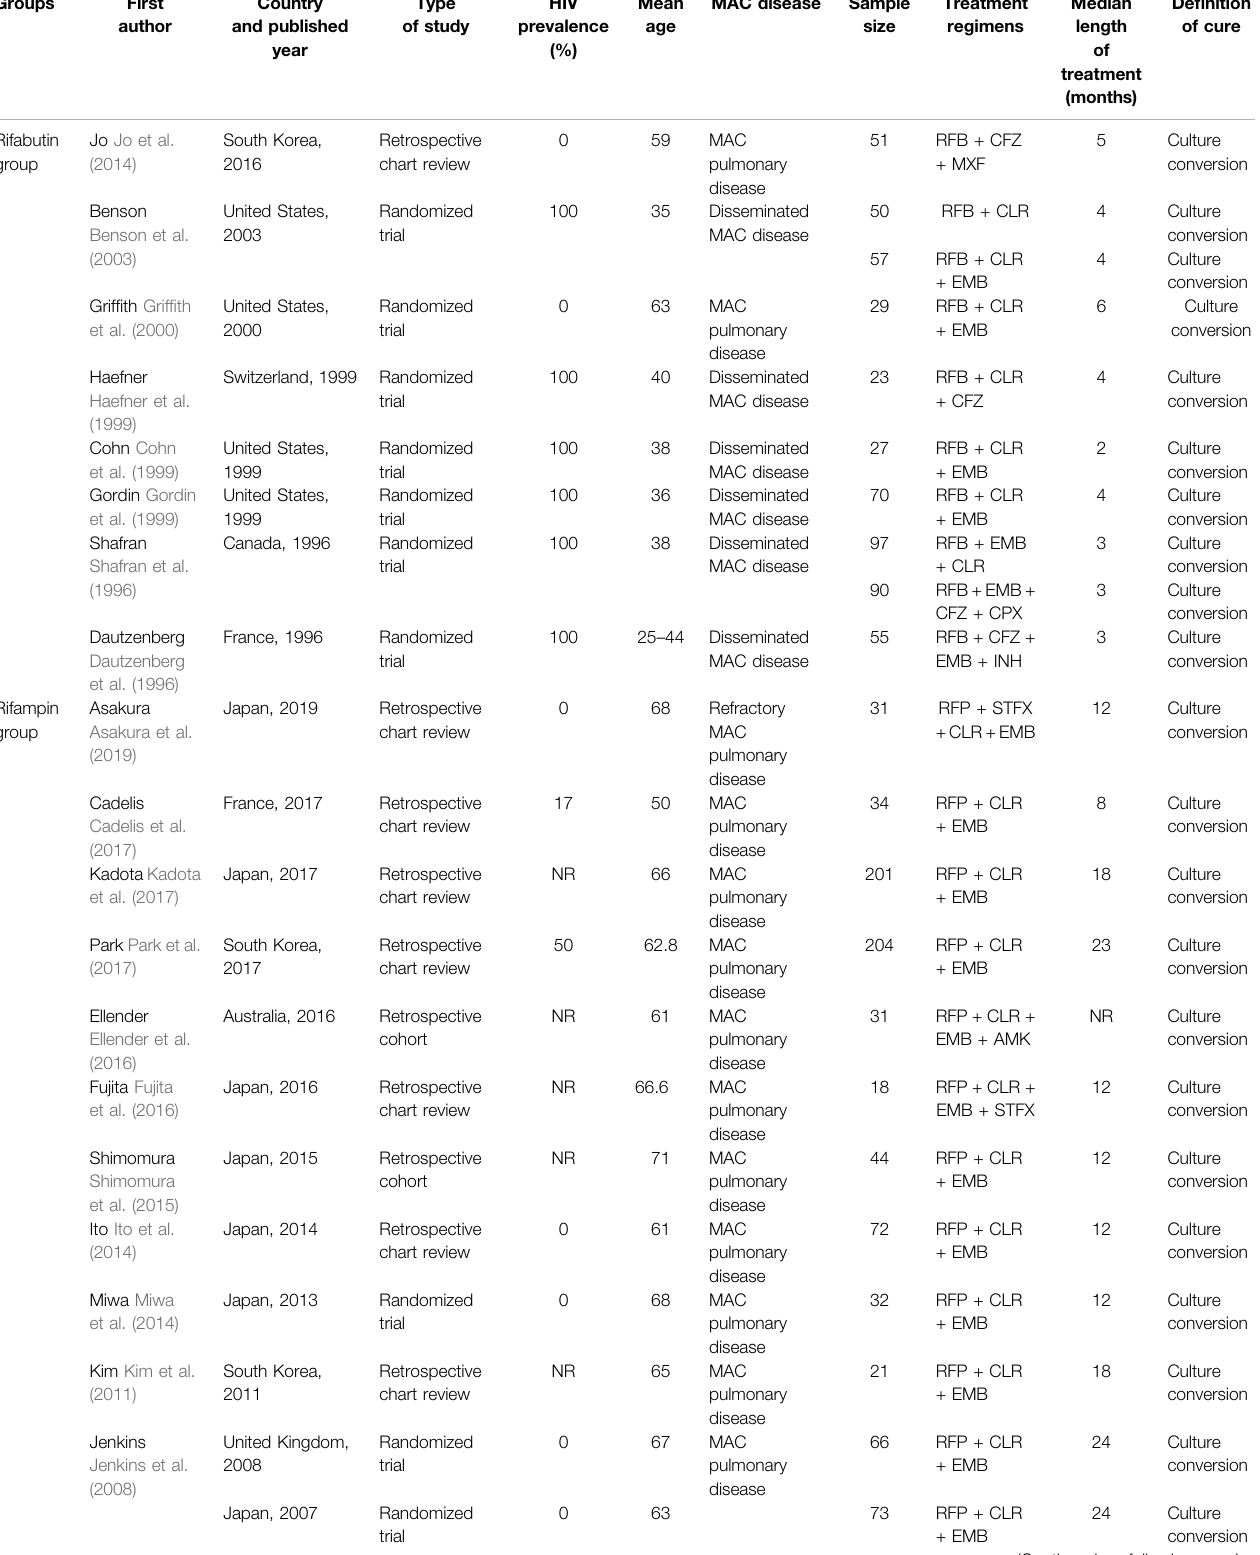
TABLE 1 | Characteristics of included